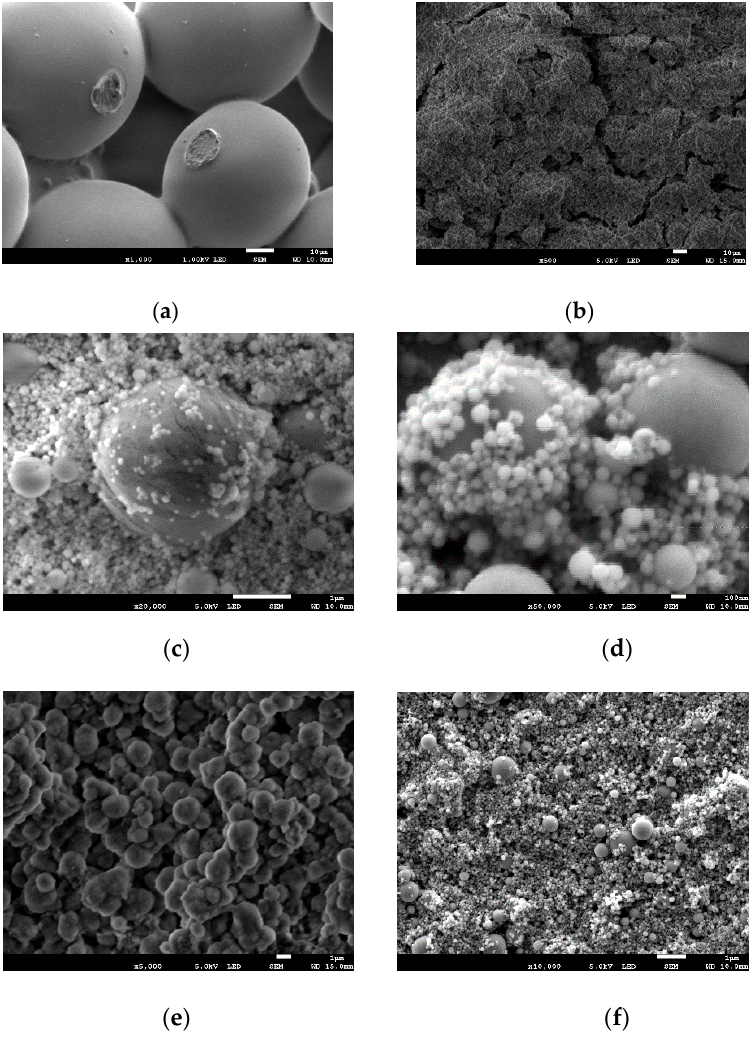
Figure 4. Results of the SEM evaluation of the surface of bone cement specimen after 1-day exposure in bacteria solution: ( a ) pure cement; ( b ) Ag; ( c ) Cu 10; ( d ) Cu 70; ( e ) Ni; ( f ) AgCu. Figure 5 shows the surfaces of the samples after 6 months of their exposure. The surface of pure bone cement reveals bacteria and biofilm. Moreover, in the case of Ni and AgCu samples, bacteria adhere and biofilm is formed on the surfaces. The surface of the bone cement sample with added Ag has visible pores, without bacteria and biofilm. On both samples Cu 10 and Cu 70, there are signs of neither bacteria nor biofilm. ( a )